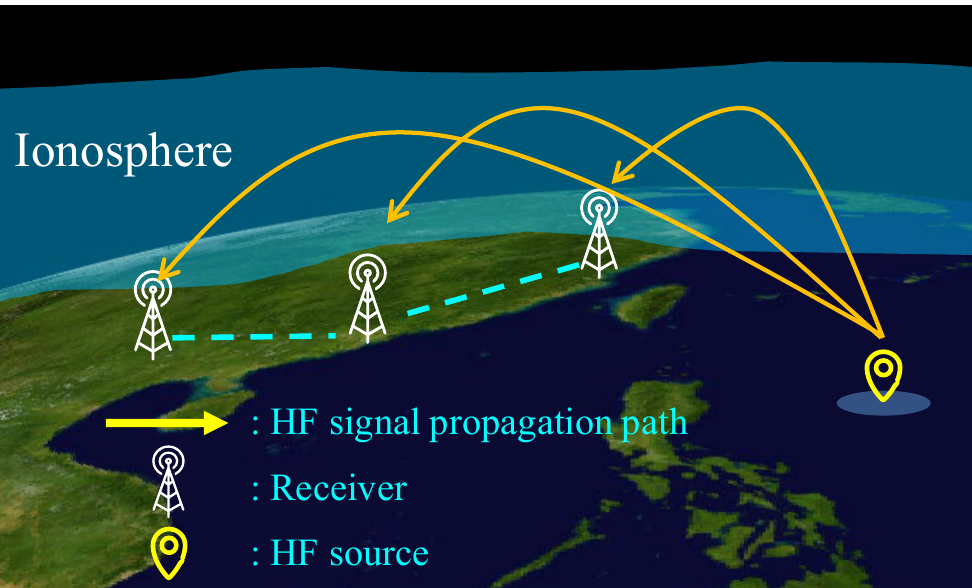
Figure 1. Schematic diagram of HF skywave source